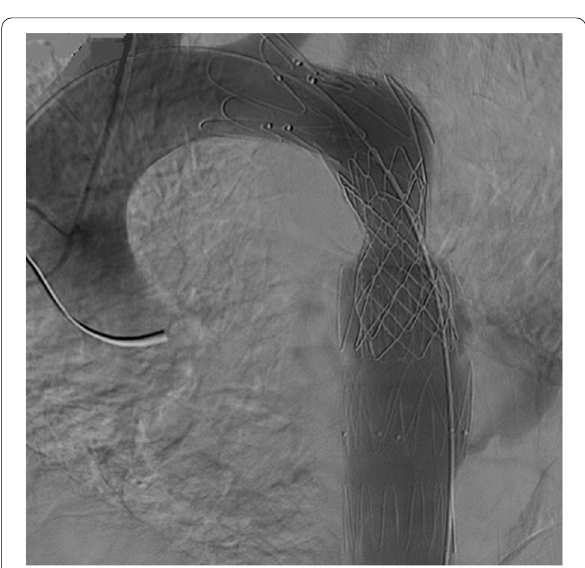
Fig. 6 Final aortic root injection revealed effective exclusion of tube graft without